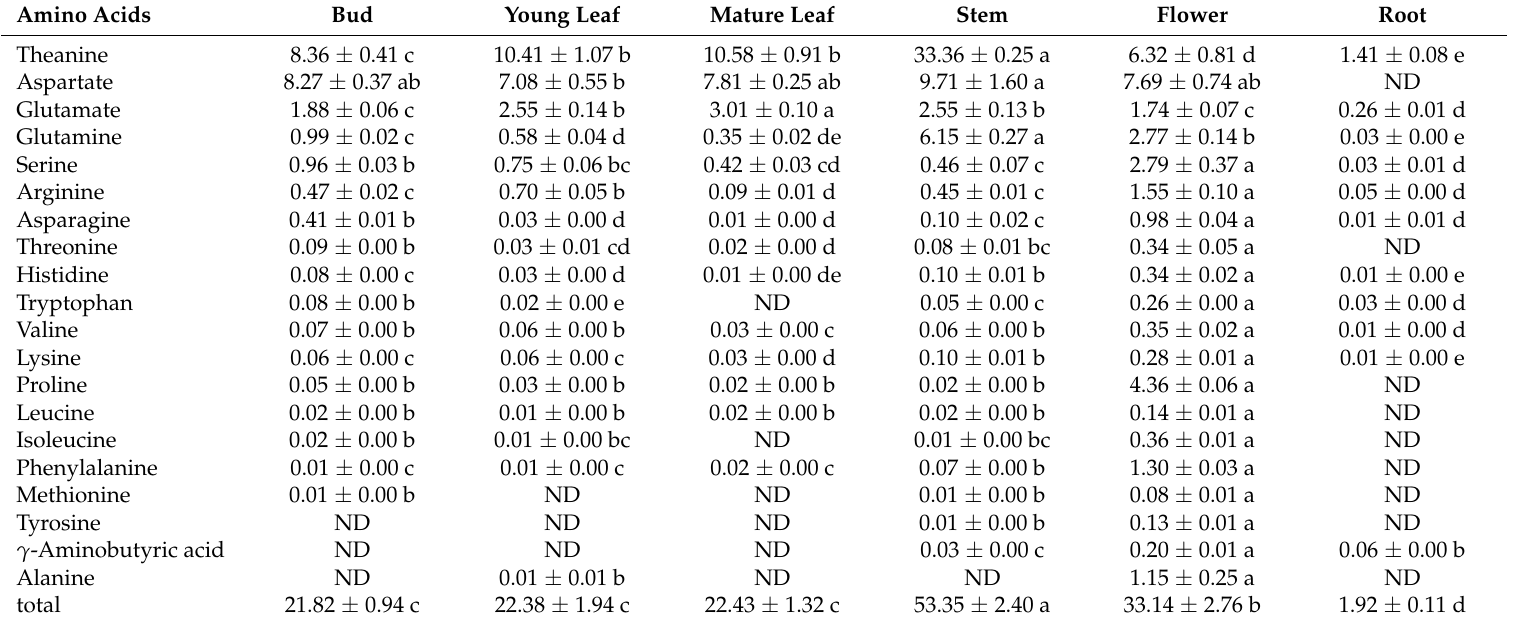
Table 2. Abundance (mg/g dry weight) of amino acids in tea plant